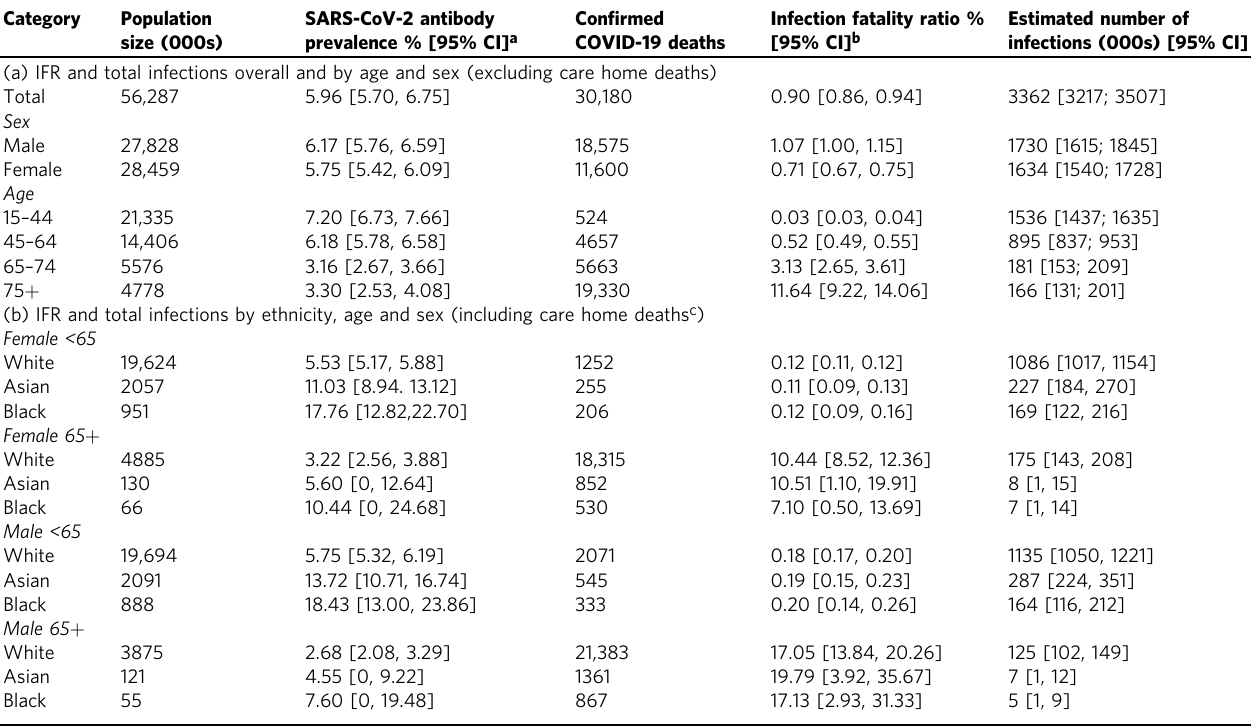
a Estimates of prevalence adjusted for imperfect test sensitivity and speci fi city, and re-weighted to account for sample design and for variation in response rate (age, sex, ethnicity and deprivation) to be representative of the England population (18 + years). b Infection fatality ratios in (a) were calculated excluding care home residents and based on con fi rmed COVID-19 death counts obtained from Public Health England 38 . Infection fatality ratios in (b) included deaths in care home residents up to 17 July 2020 obtained from Of fi ce for National Statistics 41,42 . c Deaths by ethnicity only available including care home residents. The proportions of the population and COVID-19 deaths by ethnicity, age and sex were applied to the current total population of England and the total deaths with COVID-19 on the death certi fi cate up to 17 July 2020. The data sources used are as follows: Population proportions by ethnicity 43 ; COVID deaths by ethnicity 38 ; 2011 population by ethnicity, age, sex 44 ; COVID deaths by ethnicity, age, sex 45